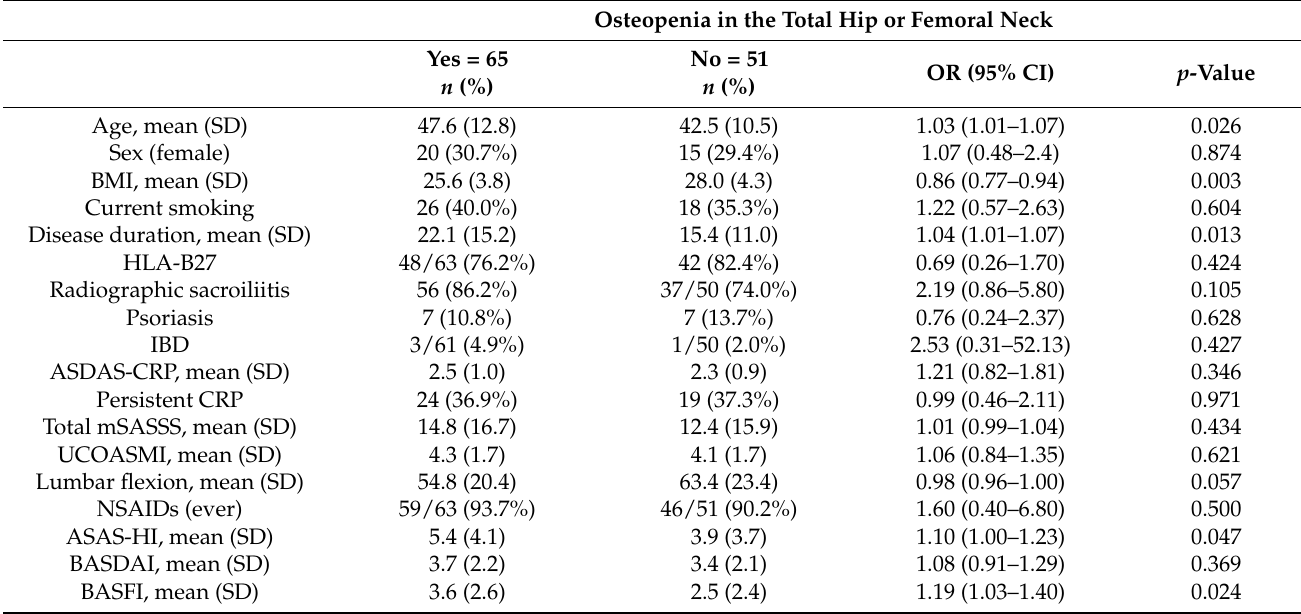
Table 3. Univariate logistic regression to evaluate the factors associated with osteopenia in the total hip or femoral